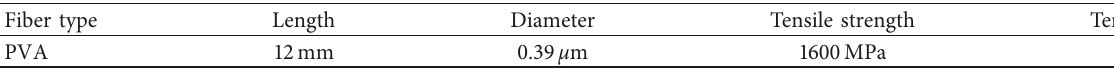
Table 2: Properties of PVA fibers.